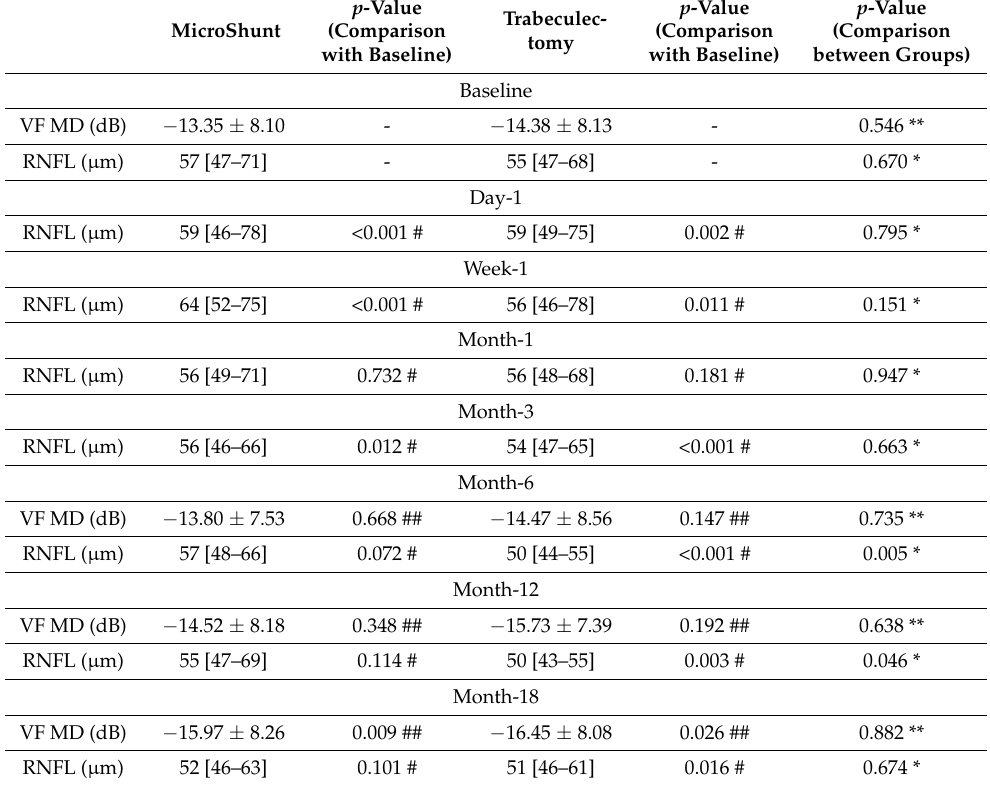
Table 2. Changes in mean ± standard deviation VF/MD and median [IQR] RNFL thicknesses during follow-up after MicroShunt and trabeculectomy (* Mann–Whitney U test; ** unpaired t -test; # Wilcoxon test, ## paired t